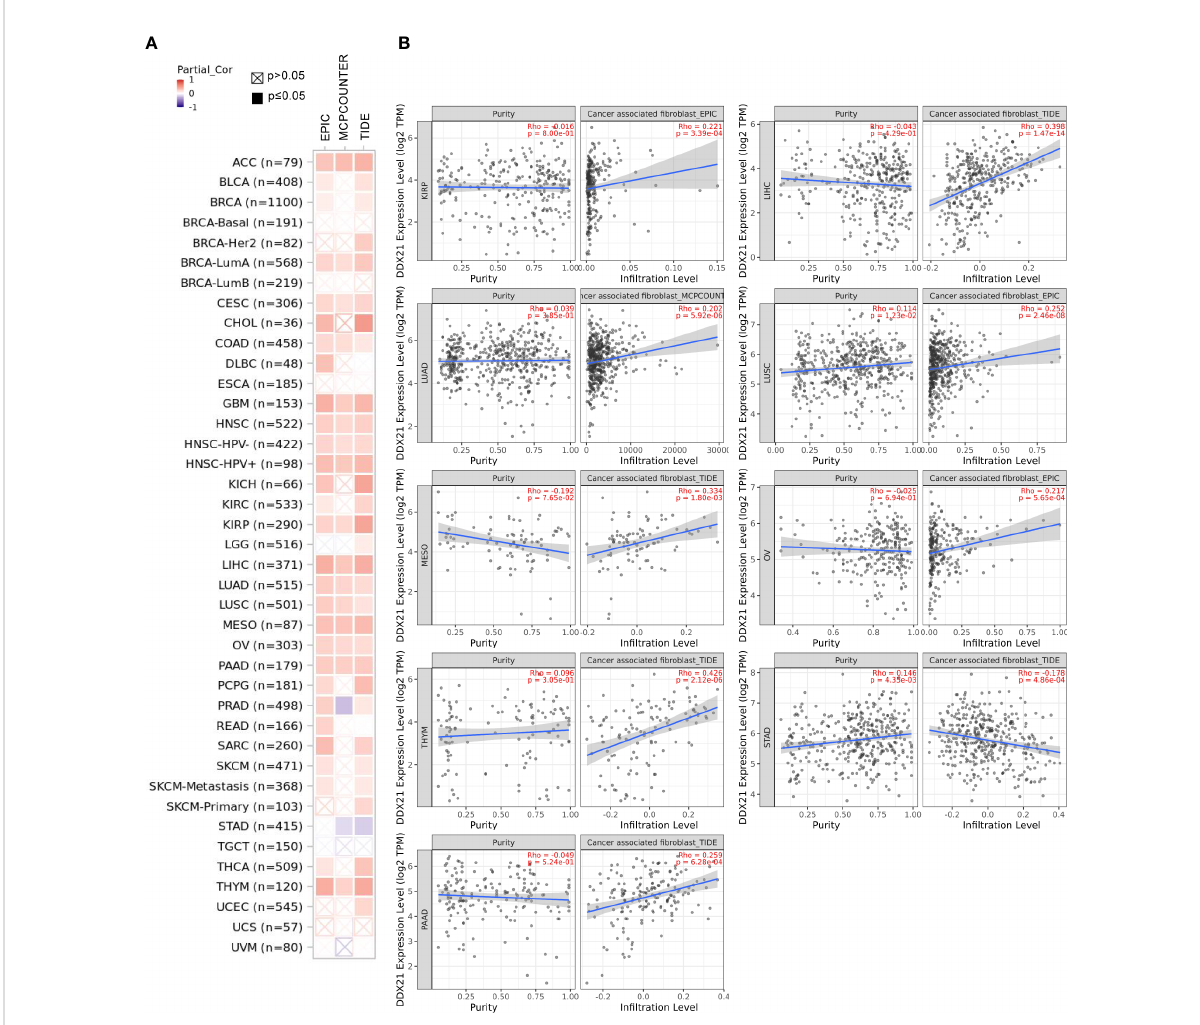
FIGURE 7 (A, B) Correlation between DDX21 expression and cancer-associated fi broblast immune in fi ltration. EPIC, MCPCOUNTER, and TIDE algorithms were used to calculate the correlation between DDX21 expression and cancer-associated fi broblast immune in fi ltration in all tumor types in